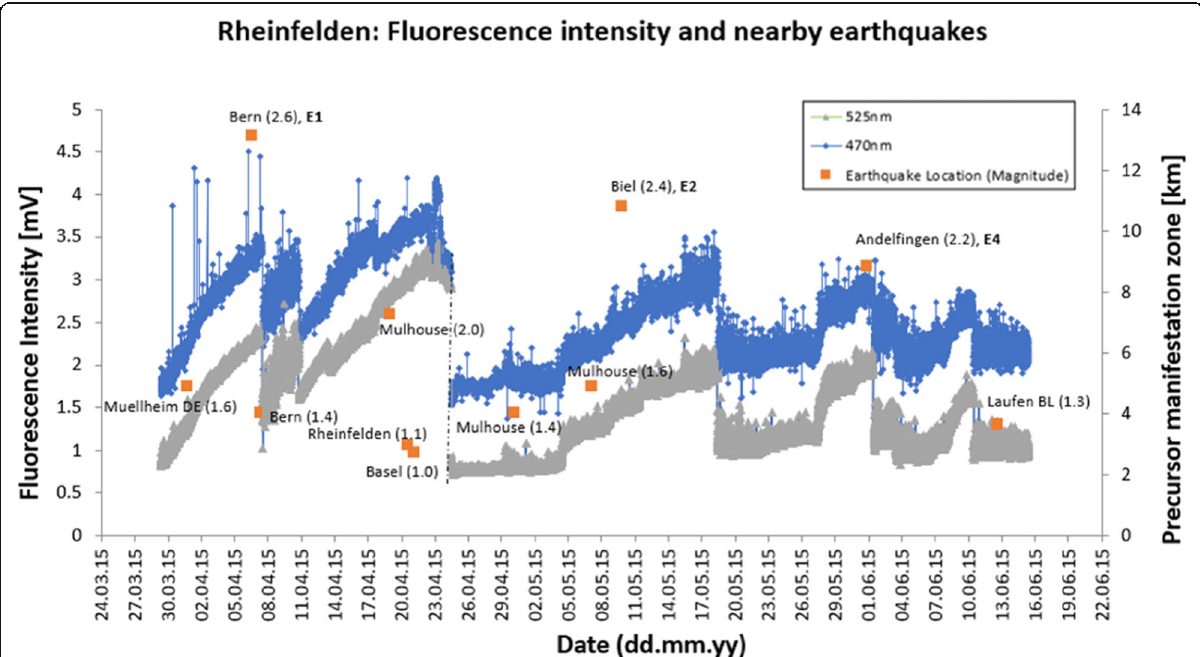
Fig. 5 Diagram of the monitored Fluorescence intensity of the thermal water in Rheinfelden (R) over the measuring period. The fluorescence intensity at wavelength 470 nm is presented in the blueish curve whereas the greyish curve presents the fluorescence intensity at 525 nm. The orange squares depict the registered earthquakes with the location and the magnitude in brackets. The earthquake close to Albstadt (E3) does not appear on the figure because of the distance between the measurement location and the epicenter, which exceeded 100 km. The earthquakes are scaled depending on their precursor manifestation zone, which was calculated by Eq. 1. The blackish – dashed line marks the interruption of the measurement because of the loss of power